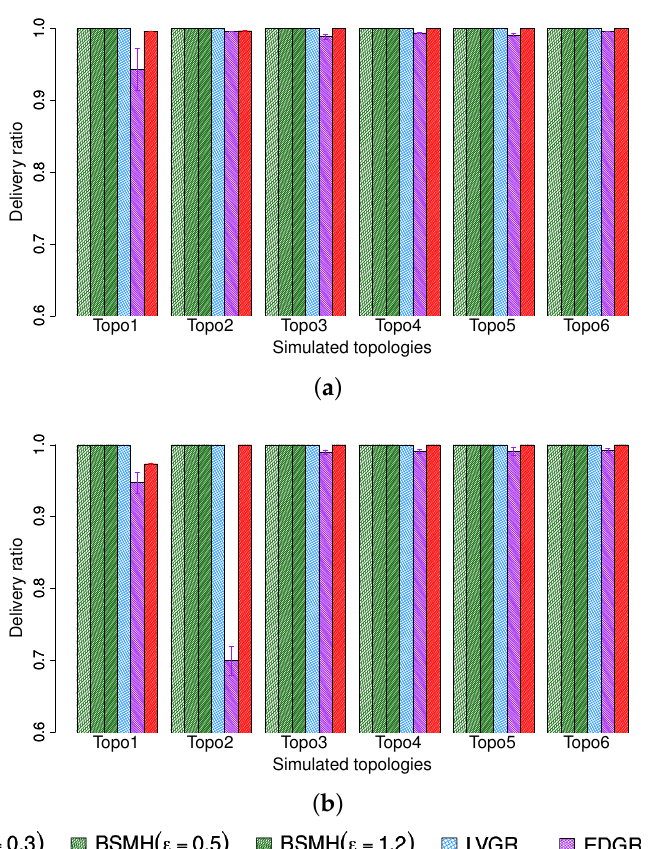
Figure 17. The ratio of the number of packets successfully delivered to the total number of packets sent. ( a ) 1-n communication. ( b ) n-n